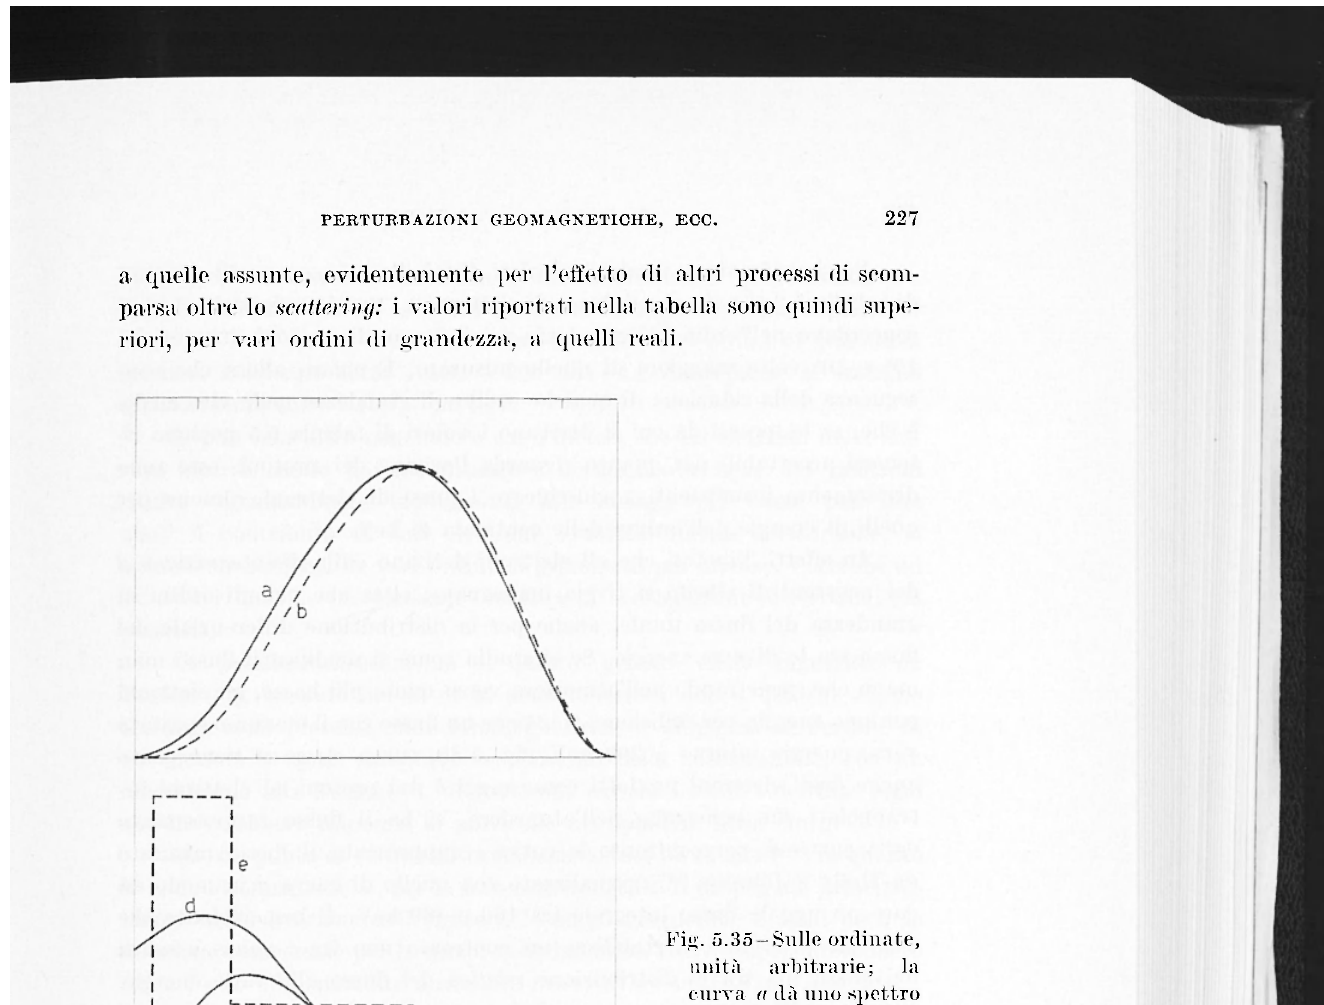
Fig. 5.35-Sulle ordinate, unità arbitrarie; la curva a dà. uno spettro differenziale, le altre curve danno flussi dif- ferenziali; T, energia cinetica in keV (se- condo